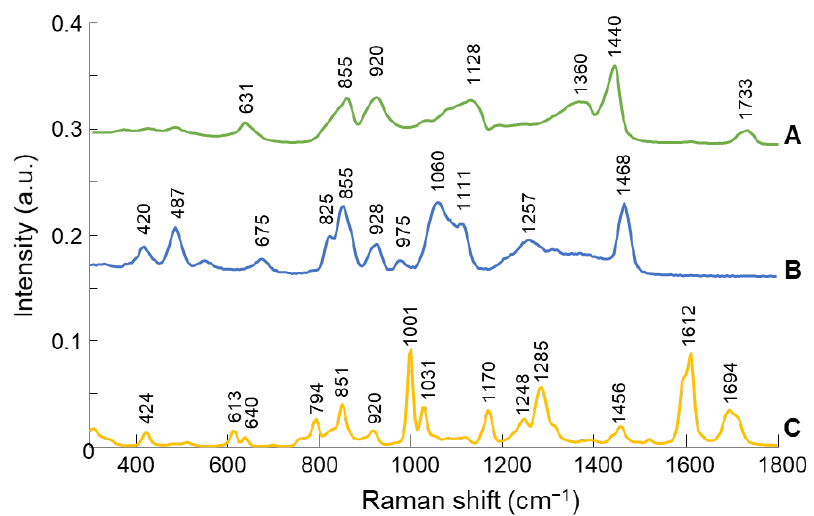
Figure 4. Raman spectra of other main compounds of PVA-GS-NanoPHE films: ( A ) control PVA film, ( B ) Glycerol, and ( C ) AMA. Spectra are offset for clarity.